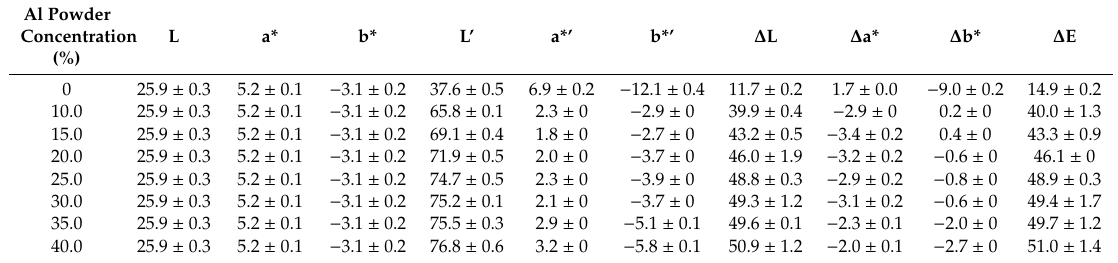
Table 5. Influence of the Al powder concentration on the L’ value of the coating. Al Powder Concentration